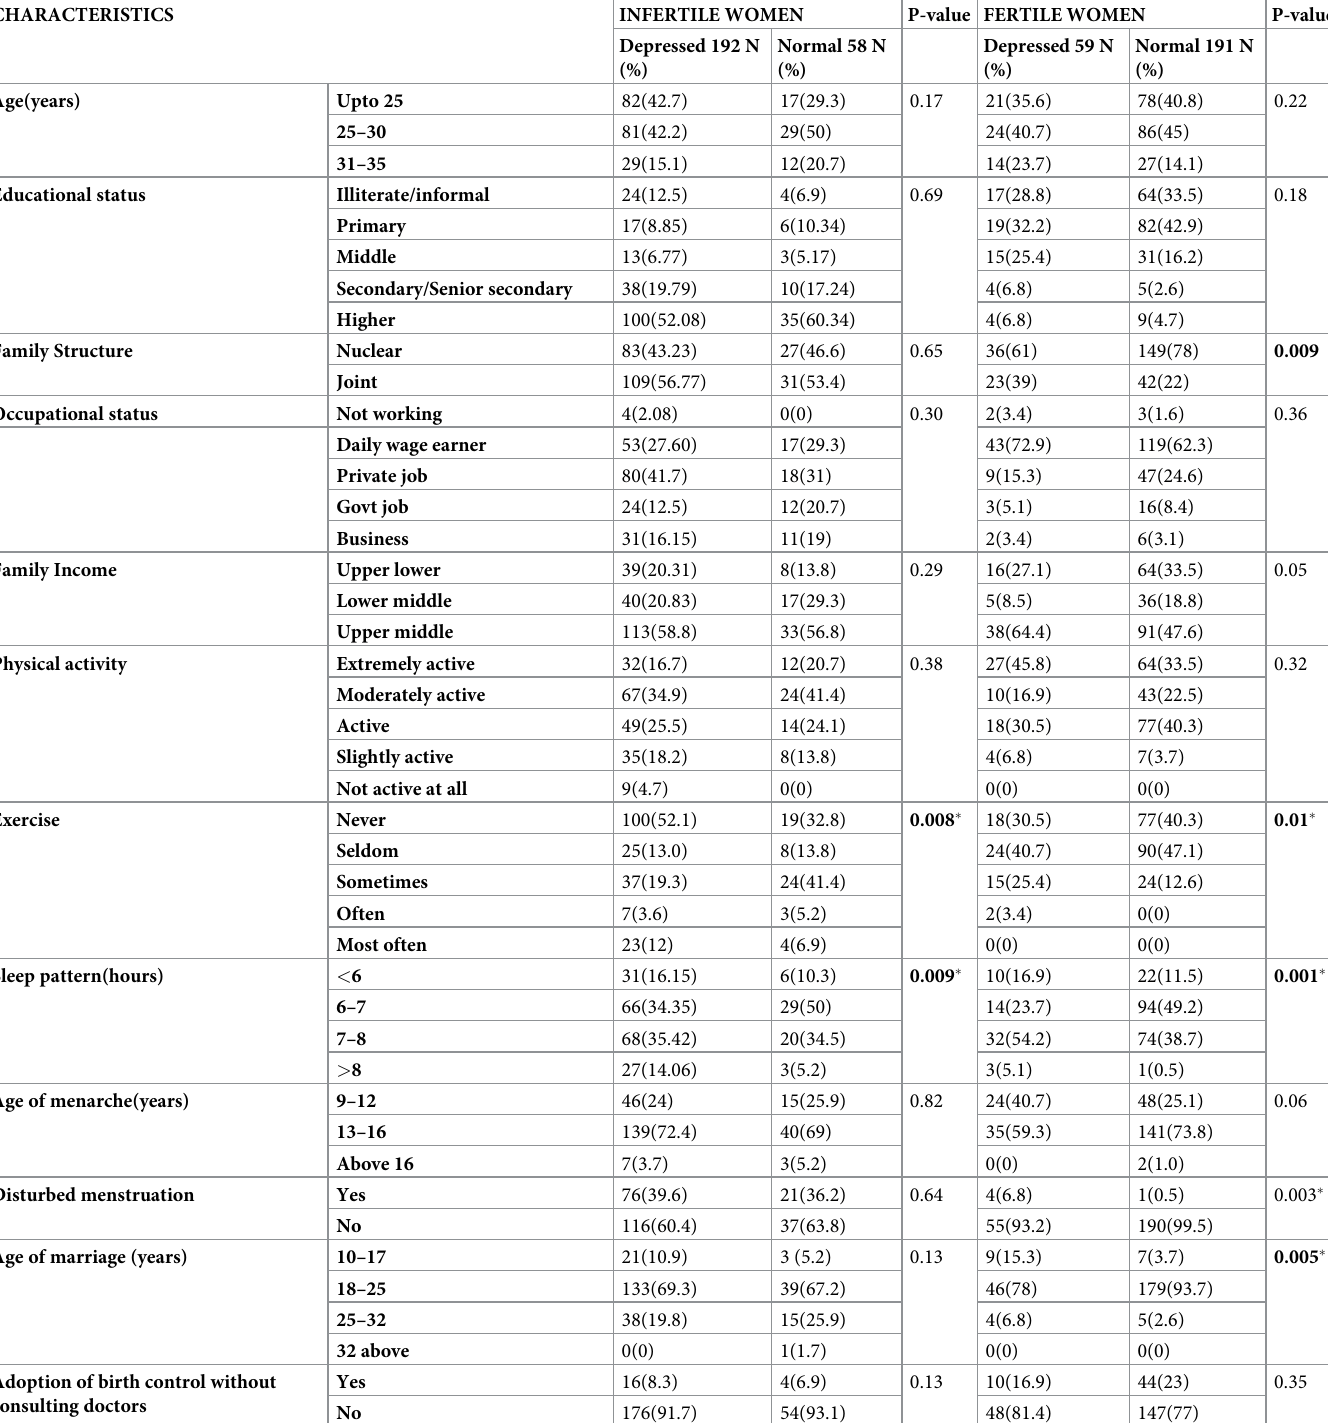
Table 5. Distribution of demographic, lifestyle variables and reproductive trajectories in infertile and fertile women in depression category.